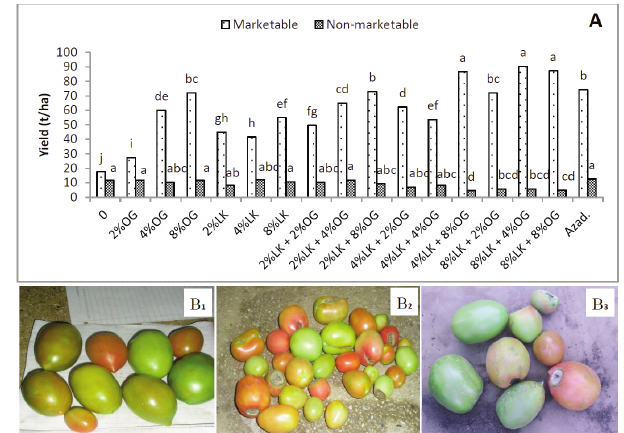
Fig. 7 ­ A. Effect of fresh plant biomass on marketable yield and fruit Quality. Means followed by the same letter in a let­ ter series within a variable are not significantly different according to Tukey’s honestly significant difference (THSD) at P≤0.05. OG = Ocimum gratissimum L. and LK = Lippia kituensis Vatke, are Soil organic amendments, 0 = no amendment and AZAD = Azadirachtin. (2% OG= 200 g OG, 4% OG= 400 g OG 8% OG= 800 g OG; 2% LK= 200g LK, 4% LK= 400 g LK, 8% LK= 800 g LK /10 Kg). B. The picture shows difference in the quality of tomato at different rates of Lippia and Ocimum amendments B1= LK+OG at 800 g; B2= 0 LK+200 g OG; B3= Non­ amended